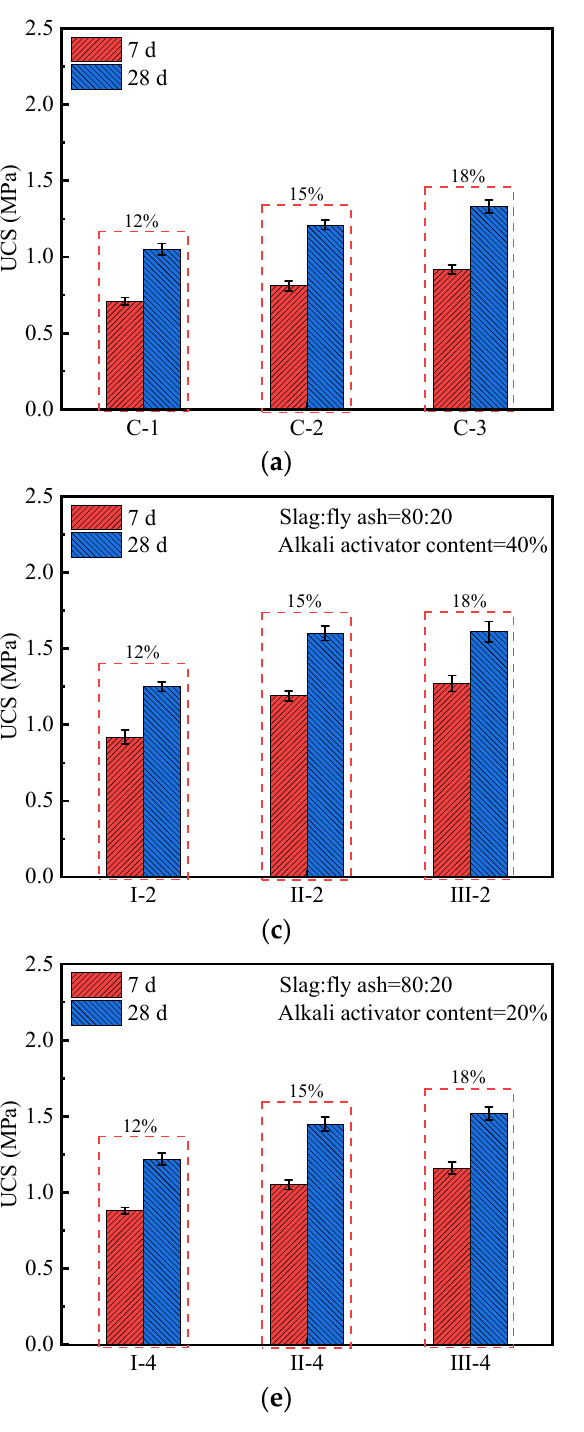
Figure 3. The UCS value of cement/geopolymer stabilized soil with different stabilizer contents (12%, 15%, and 18%): ( a ) Cement stabilized soil; ( b – f ) Geopolymer stabilized soil. It can be seen from Figure 3b–f that, for the geopolymer stabilized-soil samples, their UCS increases with the increase in the stabilizer content, but the growth rate gradually decreases. For instance, in the case where the slag:fly ash ratio is 90:10 and the